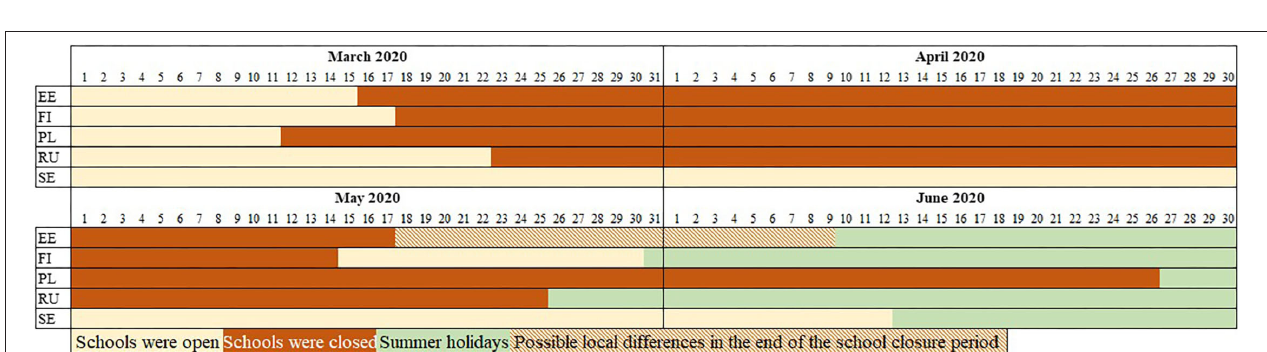
FIGURE 3 | School lockdowns in studied BSR countries in spring 2020. Source: based on ECDC data.